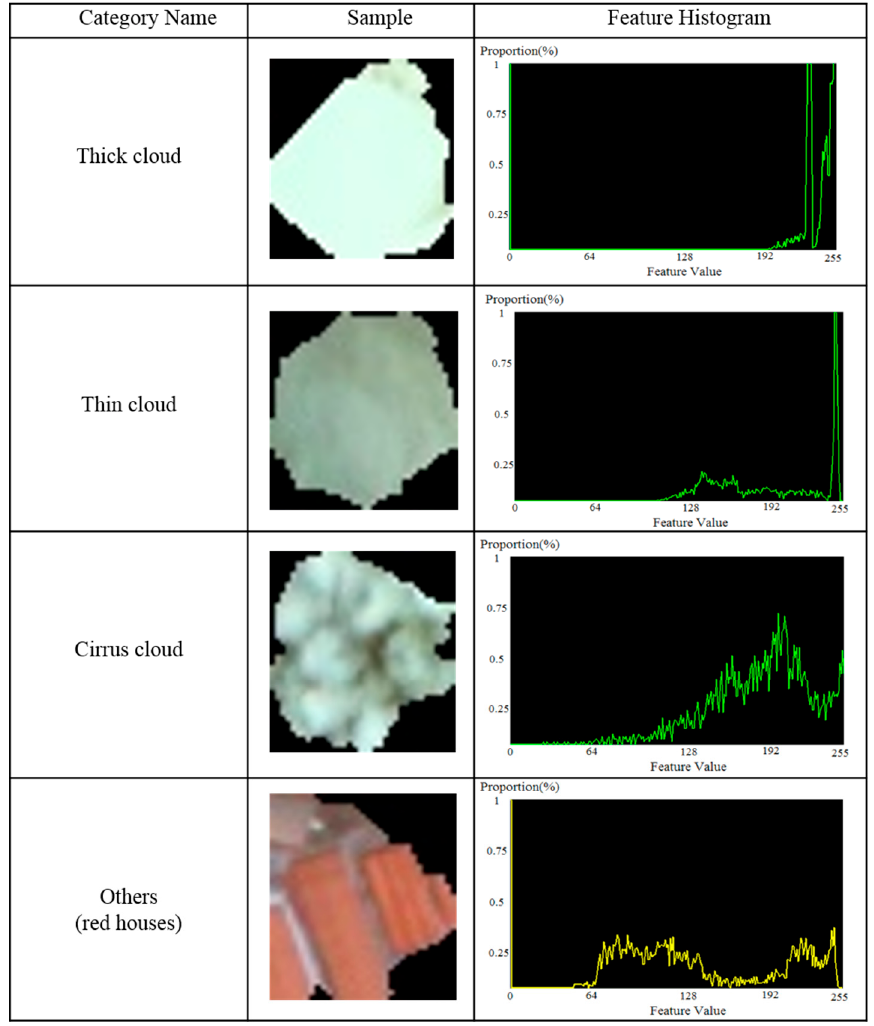
Figure 9. Four categories of superpixels (thick cloud superpixels, thin cloud superpixels, cirrus cloud superpixel, others) and their feature histogram STFH. The histogram describes the SF, TF, and FF distribution of the superpixel, the green line histograms denote the positive superpixels, and the yellow ones are the negative superpixels. The x label of the feature histogram is the feature value, ranging from 0 to 255, and the y label is the proportion of the corresponding feature value.